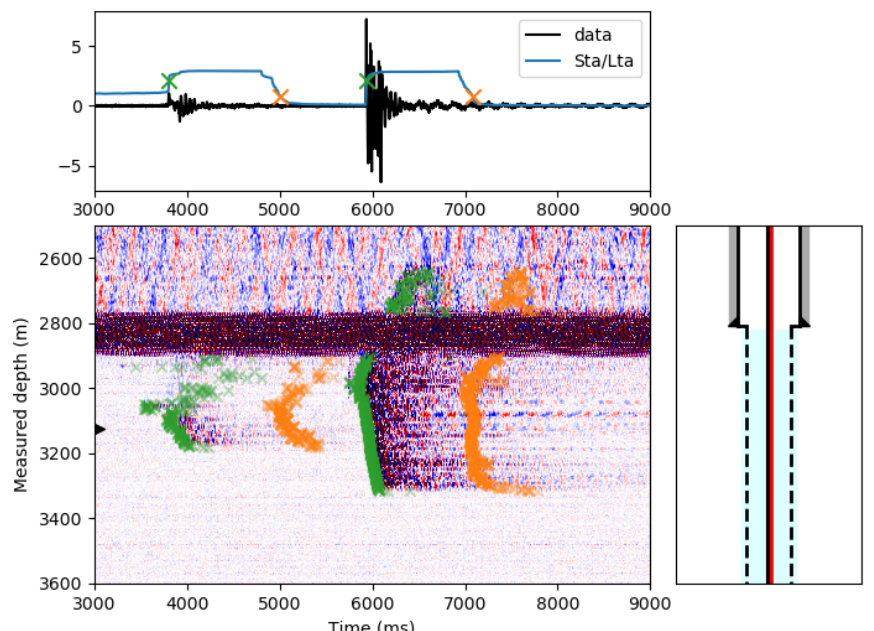
Figure 8. STA/LTA trigger algorithm applied as an automated detection method for vibrational events. Trigger start and end is marked with green and orange